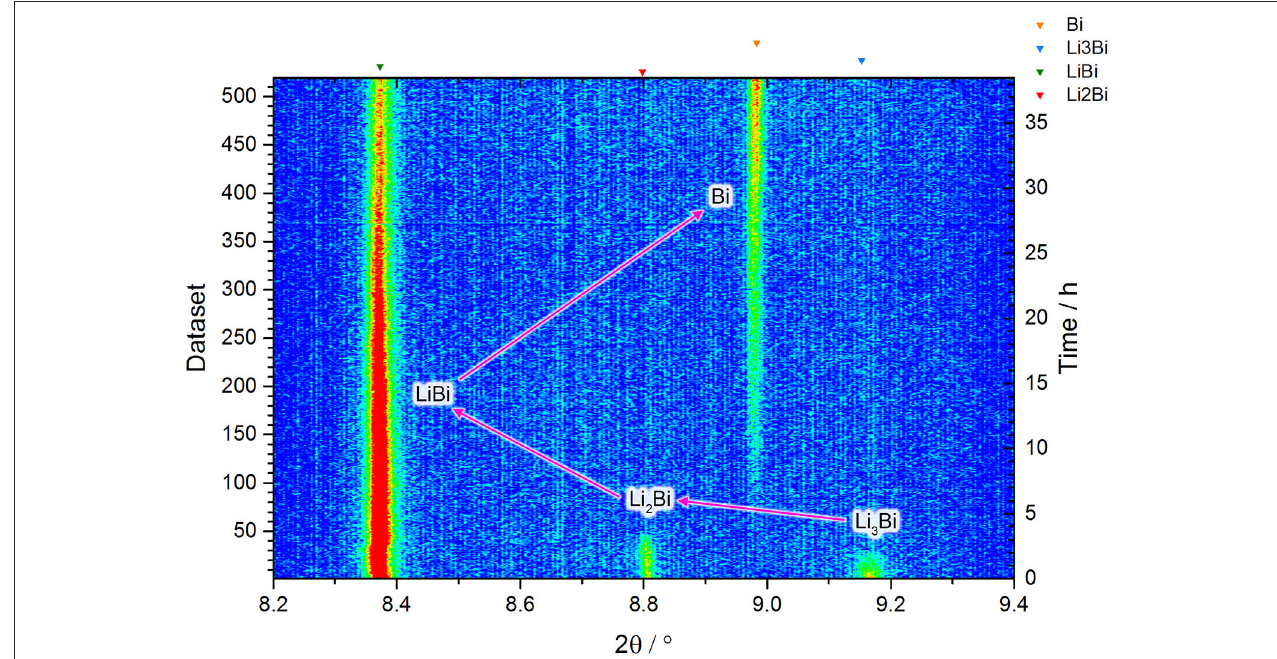
FIGURE 5 | Contour map focusing on the 8.2 ◦ < 2 θ < 9.4 ◦ region, highlighting the range of lithiated bismuth reflections. Arrows indicate a possible reaction pathway.